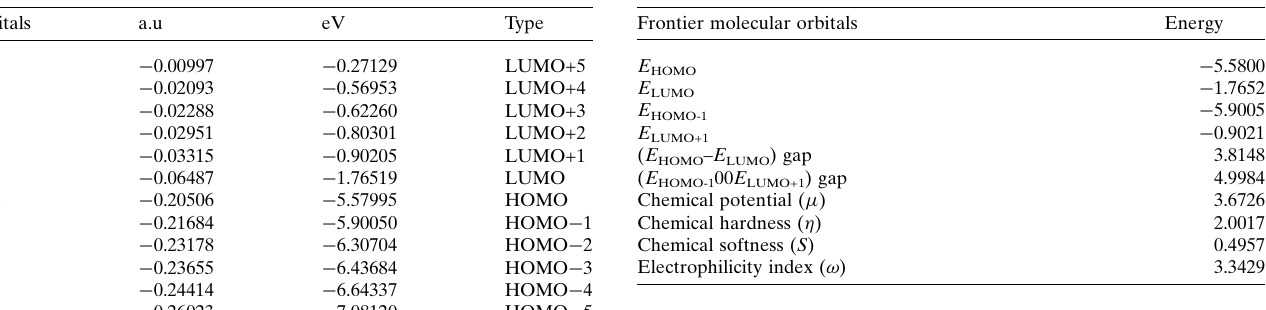
Table 4 The global reactivity descriptors of the title compound (eV).